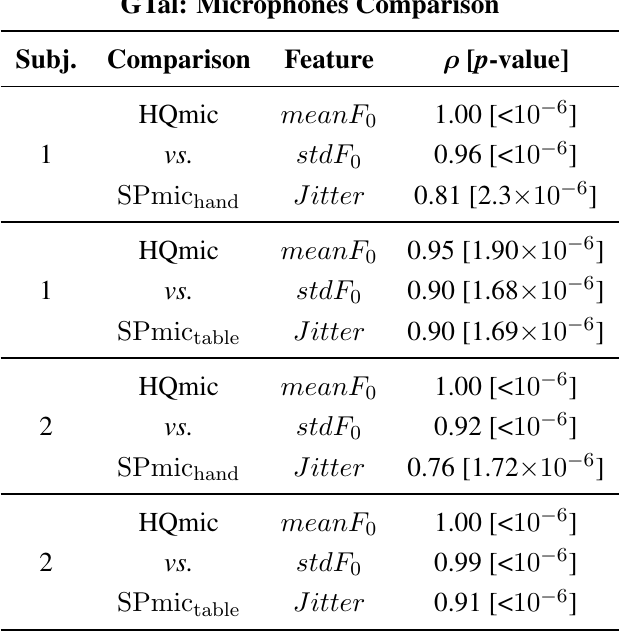
on overlapping portions of the hand